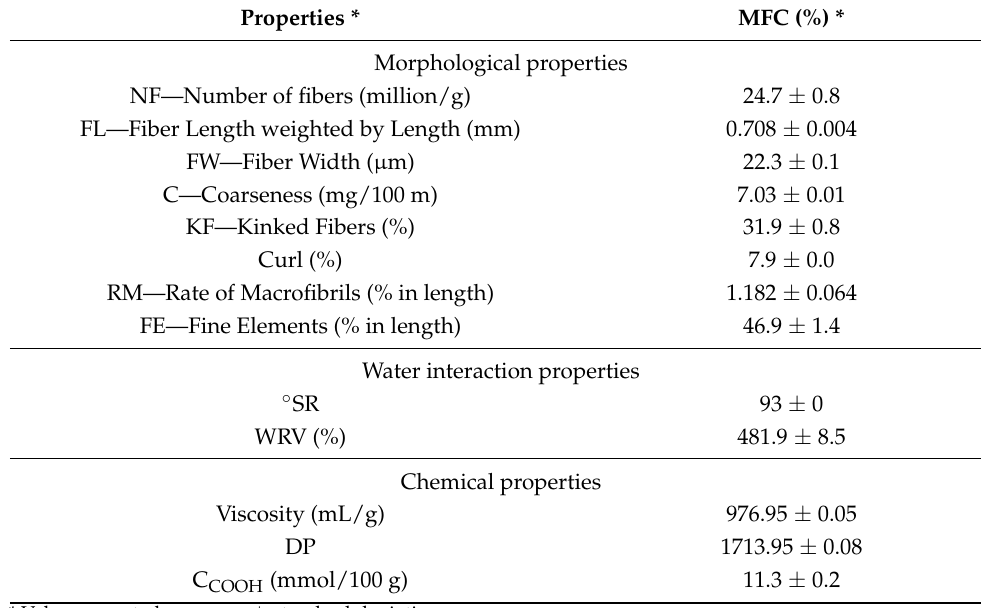
Table 2. Morphological, water interaction, and chemical properties of MFC